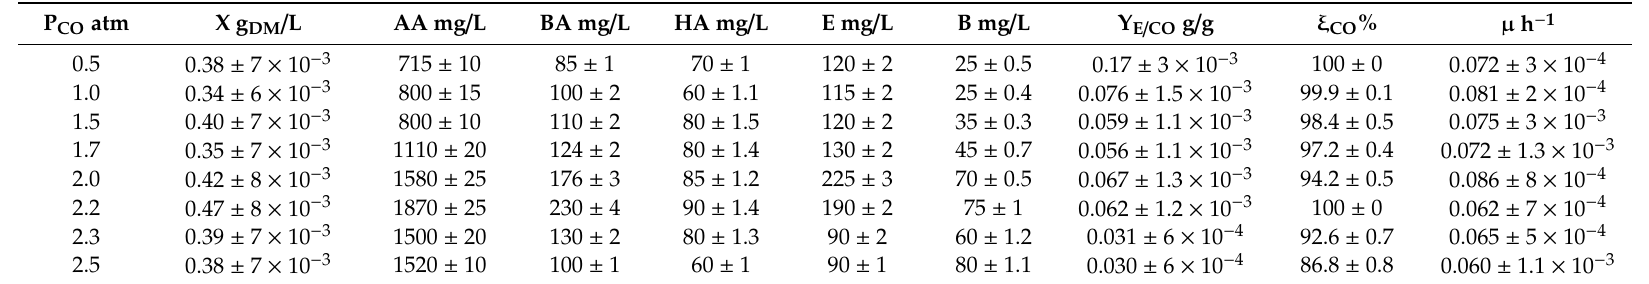
Table 2. Data from the fermentation tests carried out by setting the liquid volume at 120 mL (V L / V G = 0.92). P CO